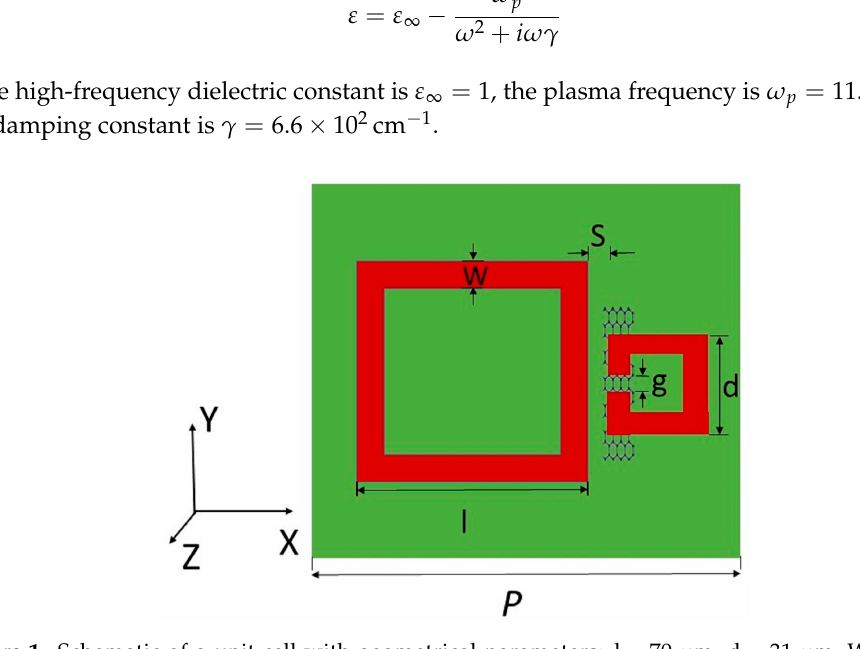
Figure 1. Schematic of a unit cell with geometrical parameters: l = 70 µ m, d = 31 µ m, W = 5 µ m, S = 5 µ m, g = 5 µ m, P = 120 µ m.